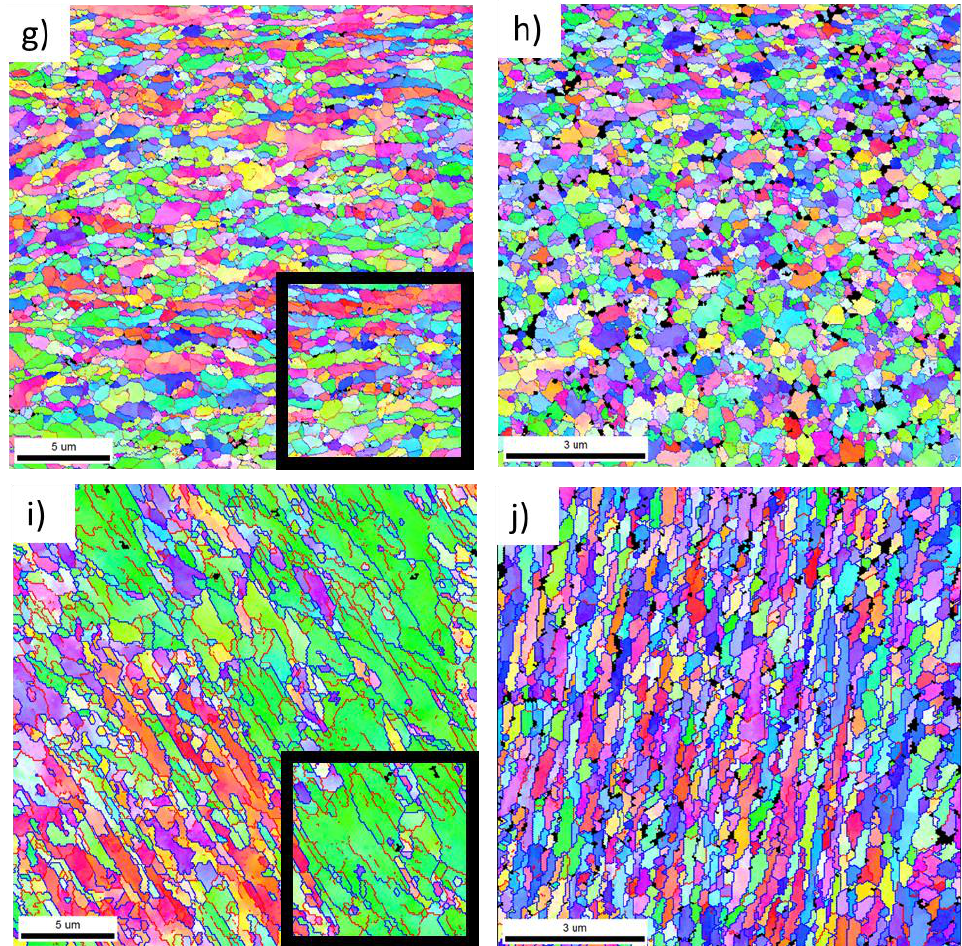
Figure 3. Orientation image maps (OIMs) reflecting the evolution of the microstructure during individual stages of CSET process. The studied areas and their designation ( a – j ) correspond to those marked in Figure 2b (A–J, respectively) and in Table 2. The orientation of the OIMs relative to the setup is the same as presented in Figures 1 and 2. Black squares in the right bottom corner in OIMs ( a – g , i ) represent the size of the smallest maps in ( h , j ).